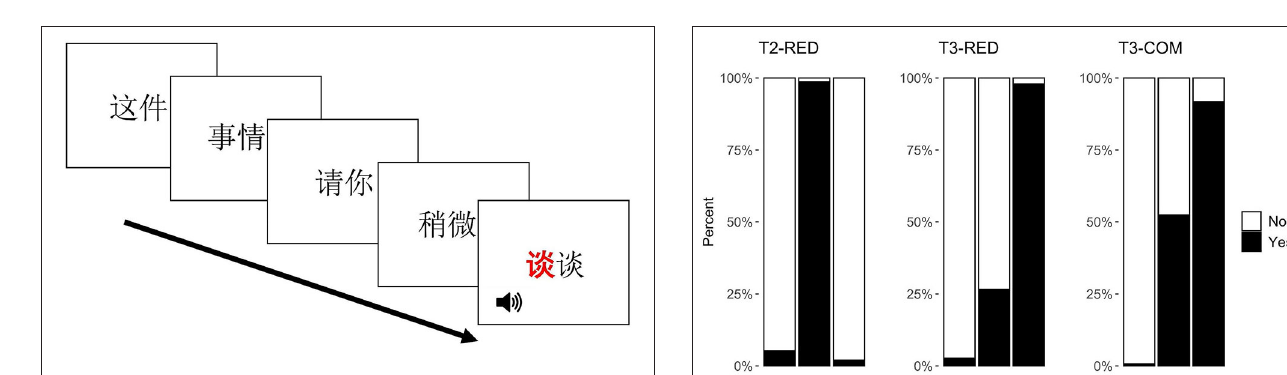
FIGURE 1 | RSVP Experiment Demo (left to right: zhe-jian “this,” shi-qing “thing,” qing-ni “please,” shao-wei “a little bit,” tan-tan “to talk”).